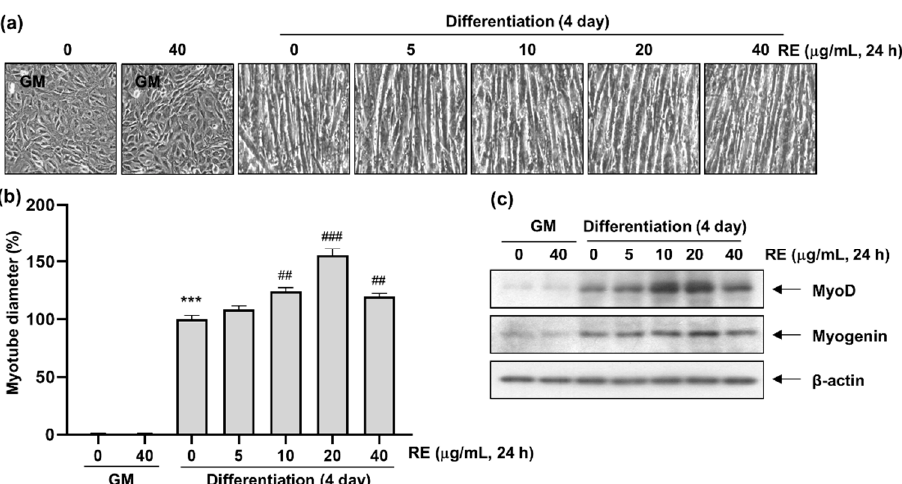
Figure 2. Effects of rosemary extract (RE) on C2C12 myoblast differentiation. C2C12 cells were cultured in differentiation medium for 4 d, until completely differentiated, treated with indicated concentrations of RE, and cultured for additional 24 h. ( a ) Phase-contrast micrographs of C2C12 cells before and after 4 d of differentiation when cultured with different concentrations of RE. 200 × magnification; ( b ) C2C12 cell diameter before and after 4 d of differentiation when cultured with different concentrations of RE. Values and error bars indicate means ± SD of three separate experiments. ***, significant difference between RE- and vehicle-treated cells before differentiation (ANOVA, p < 0.001); ##, significant difference between RE- and vehicle-treated cells after differentiation (ANOVA, p < 0.01); ###, significant difference between RE- and vehicle-treated cells after differentiation (ANOVA, p < 0.001); ( c ) Expression of differentiation-related proteins before and after 4 d of differentiation when cultured with different concentrations of RE. C2C12 myotubes were cultured with RE for 24 h, and then cell lysates were immunoblotted with MyoD and myogenin antibodies. Representative results of three independent experiments are shown. β -Actin was used as a loading control. GM: growth medium.